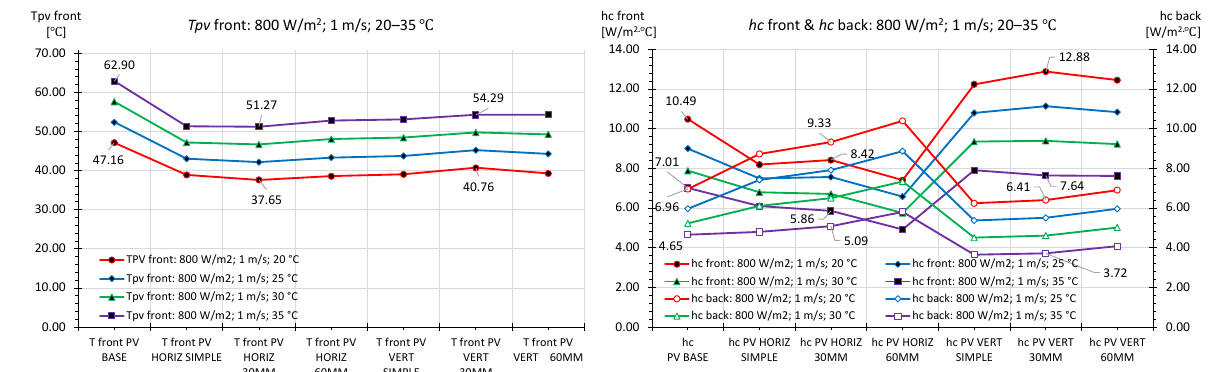
Figure 8. Variation of average operating temperature and convective heat transfer coefficient for studied cases. G = 1000 W/m 2 , v air = 1 m/s and t air = 20–35 °C.